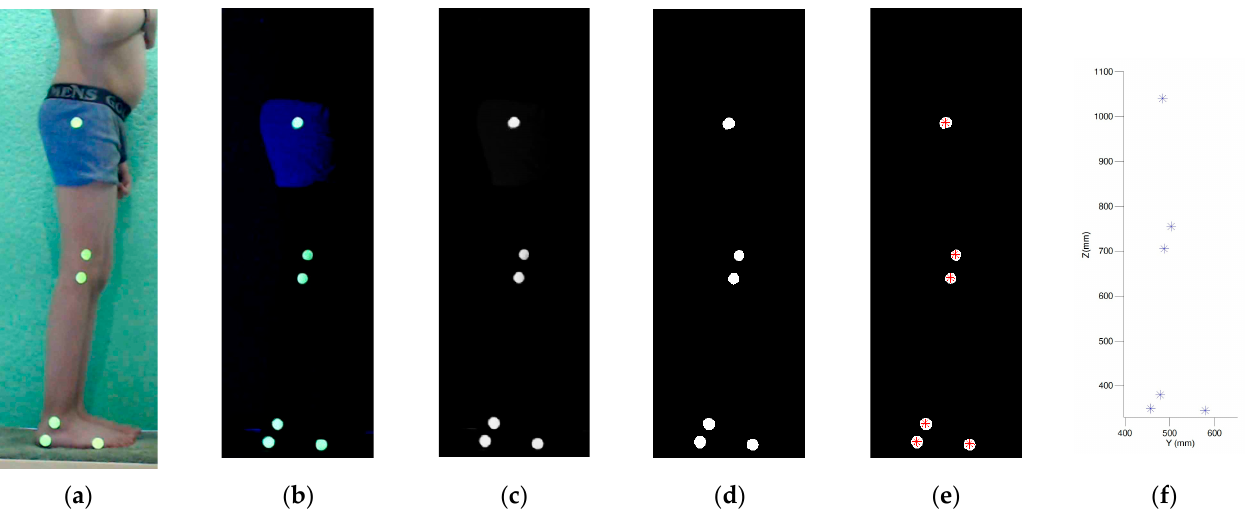
Figure 6. Results of the MVS: ( a ) image using standard light, ( b ) image using black light, ( c ) image converted to greyscale, ( d ) binarized image, ( e ) location of centroids in pixels, ( f ) 3D reconstruction of the centroids’ markers.